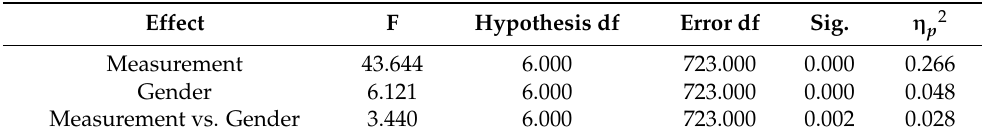
Table 4. Significance values and effect size of the initial–final vs. gender